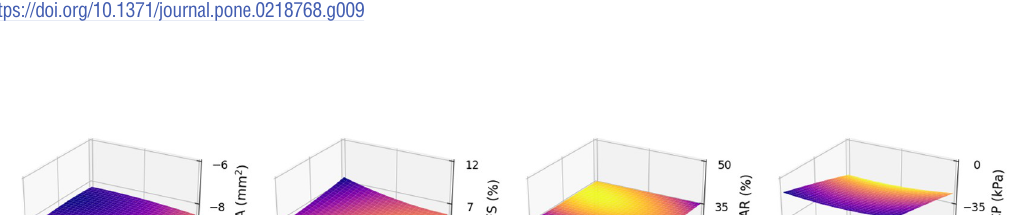
Fig 9. Response surfaces highlighting the combined influence of A RCP ), holding t and l constant at their baseline values ( t = 150 μ m and l = 1050 μ m).